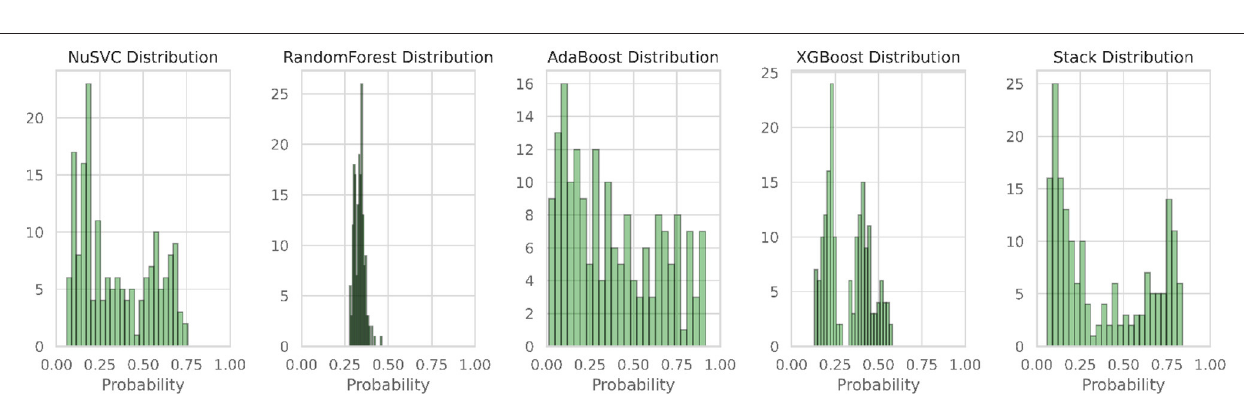
FIGURE 14 | Probability distributions of the four classifiers and multistage heterogeneous stacking ensemble classification model